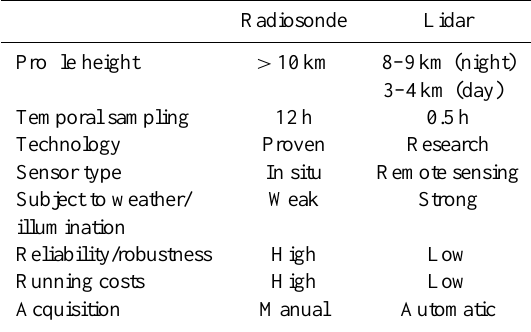
Table 3. Radiosonde and lidar measurement